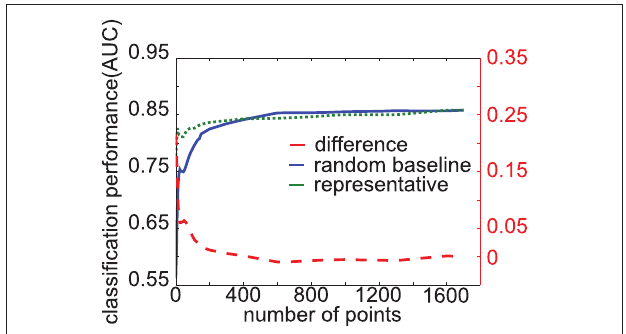
Figure 4 | Classification performance for aromatic property. The ordinate stands for the number of sampled points for classification. Curves depict performance in AUC with taking most representative points (solid line), randomly sampled points (dashed line), and the difference between the two